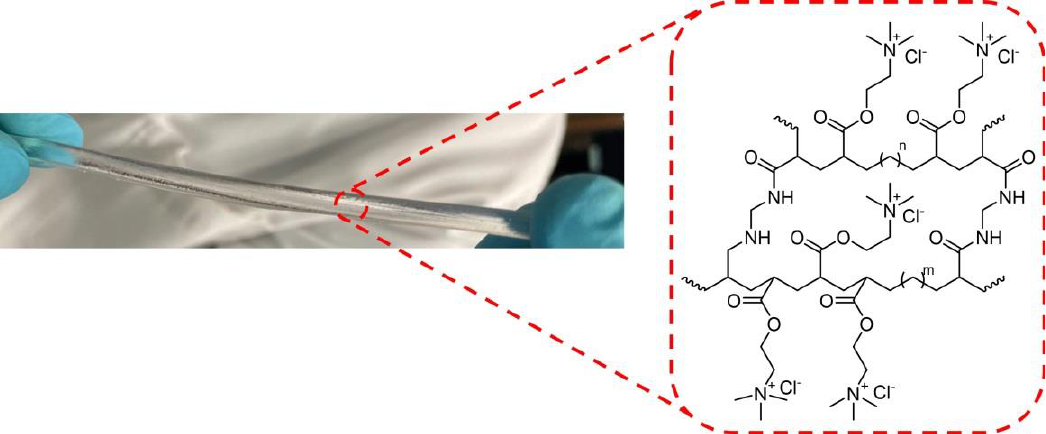
Figure 2. Chemical structure of the CN-hydrogel and digital image of the hydrogel cylinder used for the measurements.